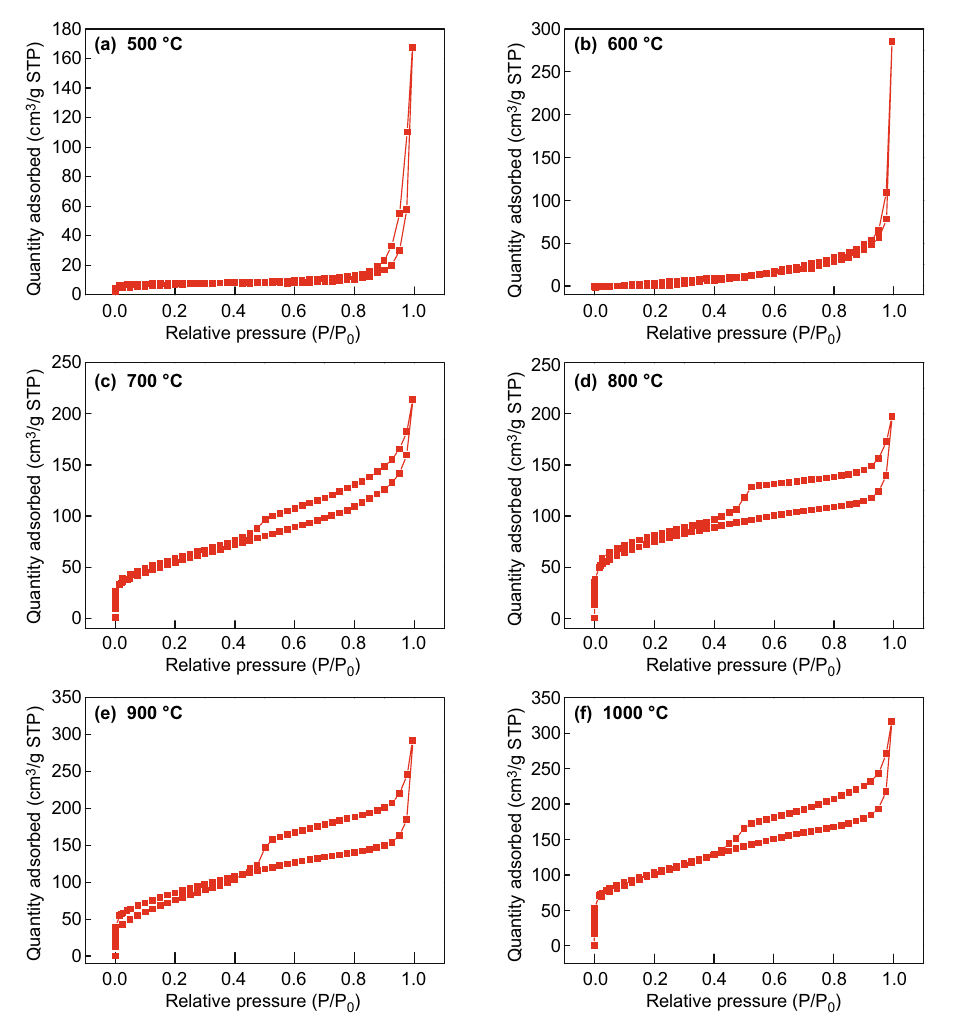
Fig. 7 N 2 adsorption–desorption isotherm of the samples at different carbonization temperature: a 500 °C, b 600 °C, c 700 °C, d 800 °C, e 900 °C, and f 1000